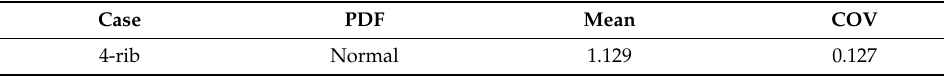
Table 22. Bias factor for the shear resistance formula ( P u ) [26].